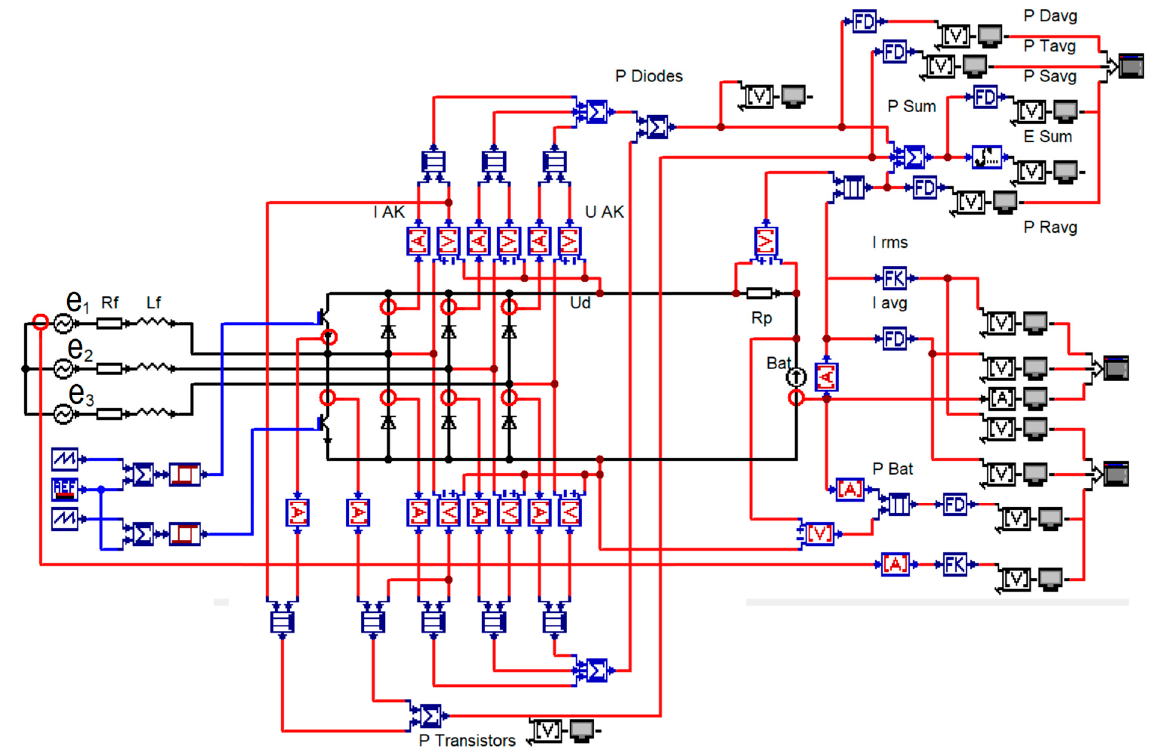
Figure 6. Simulation circuit of the three-switch converter.